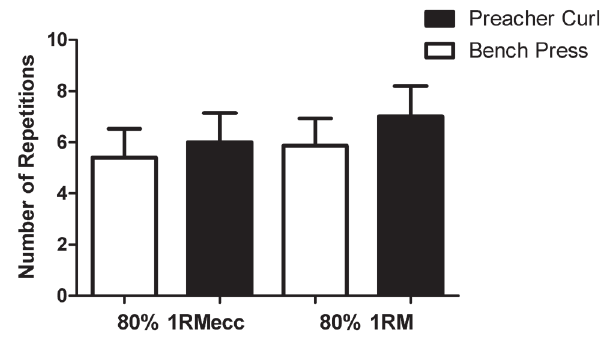
Figure 2. Maximum number of repetitions in the bench press and the preacher curl exercises. The data are expressed as mean ± SD ( n =